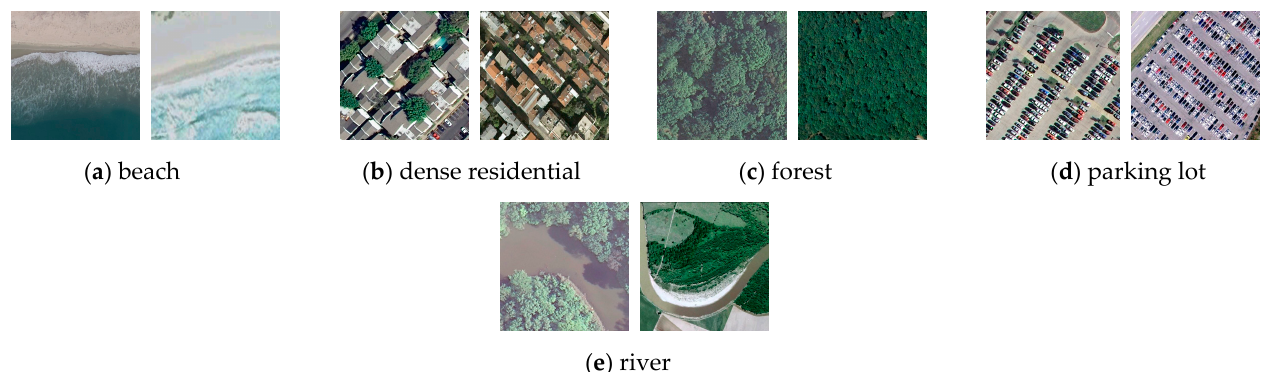
Figure 9. Samples of each common class for UCM ( left ) and RSI-CB256 (RSI) ( right ).